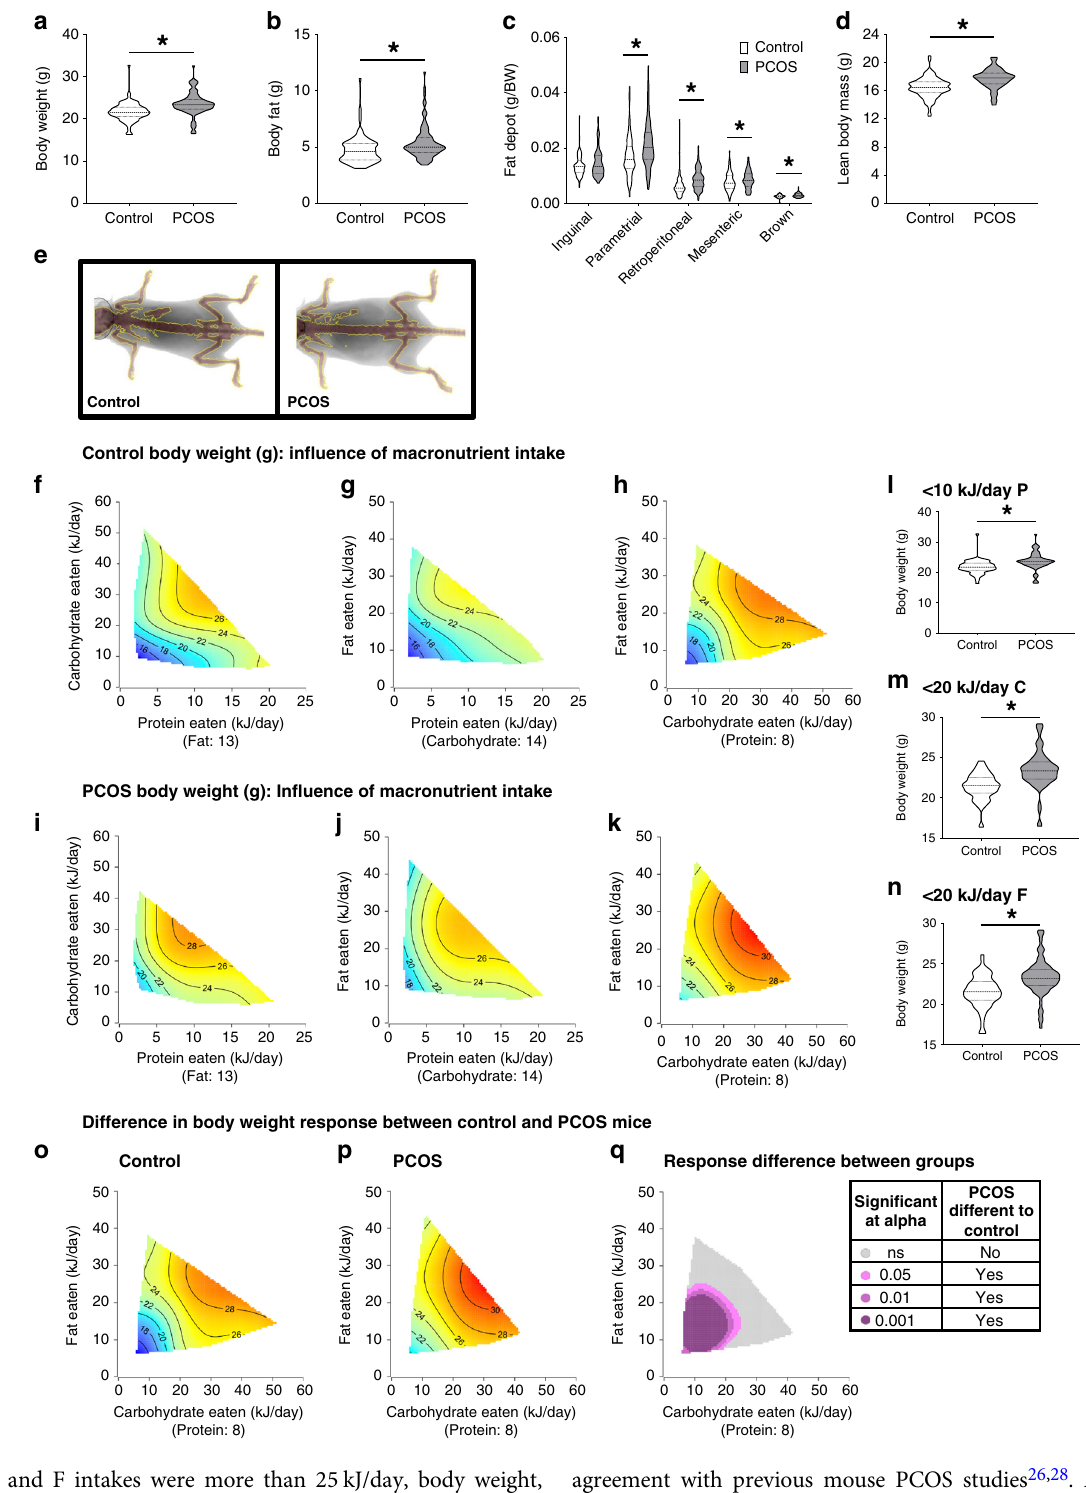
when C and F intakes were more than 25 kJ/day, body weight, although still greater in PCOS mice, was in fl uenced similarly by macronutrient intake in PCOS and control mice (Fig. 2q). Diet variations do not impact PCOS traits in adipose tissue . When data across all diets was combined, hyperandrogenism induced a signi fi cant increase in adipocyte area within PCOS parametrial fat pads compared to control mice (1729 ± 54.3 µm 2 vs. 1573 ± 50.6 µm 2 ) ( P = 0.04, Fig. 4a, b). This fi nding is in